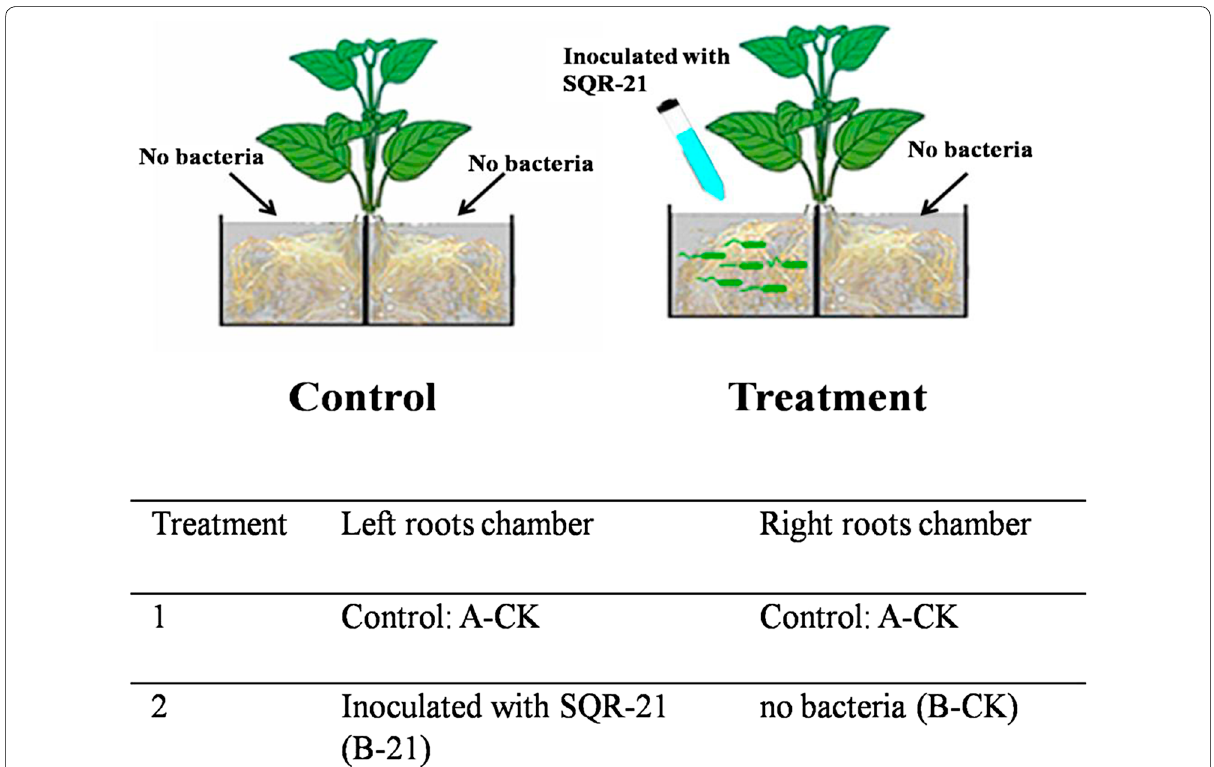
Fig. 1 Schematic representation of the experimental design with the hydroponic split-roots system, which allows SQR-21 and watermelon roots co-cultured together in one half box, and the remaining half roots at the other half box were not contaminated by the